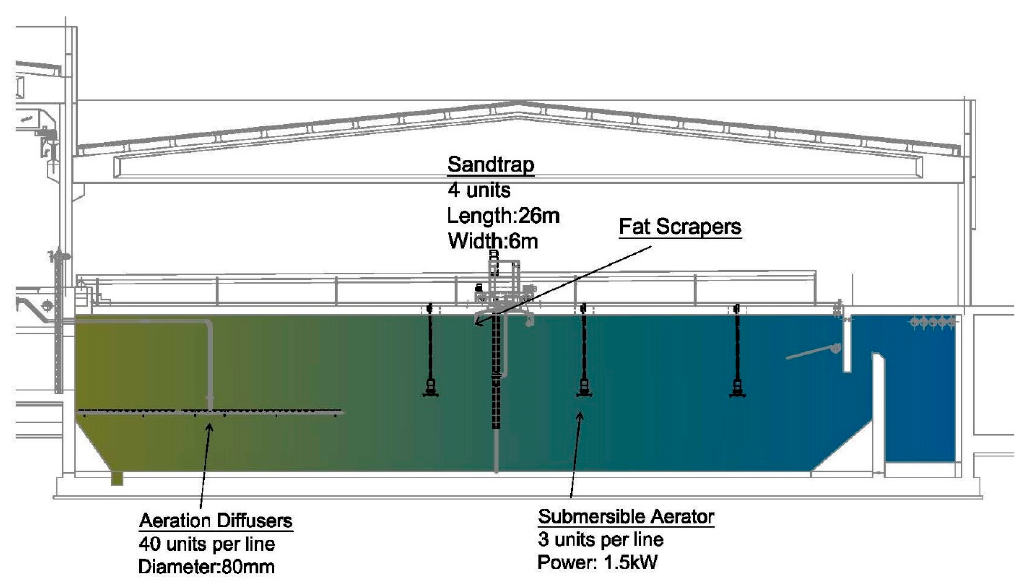
Figure 2. A sectional view of a FOG concentrator.